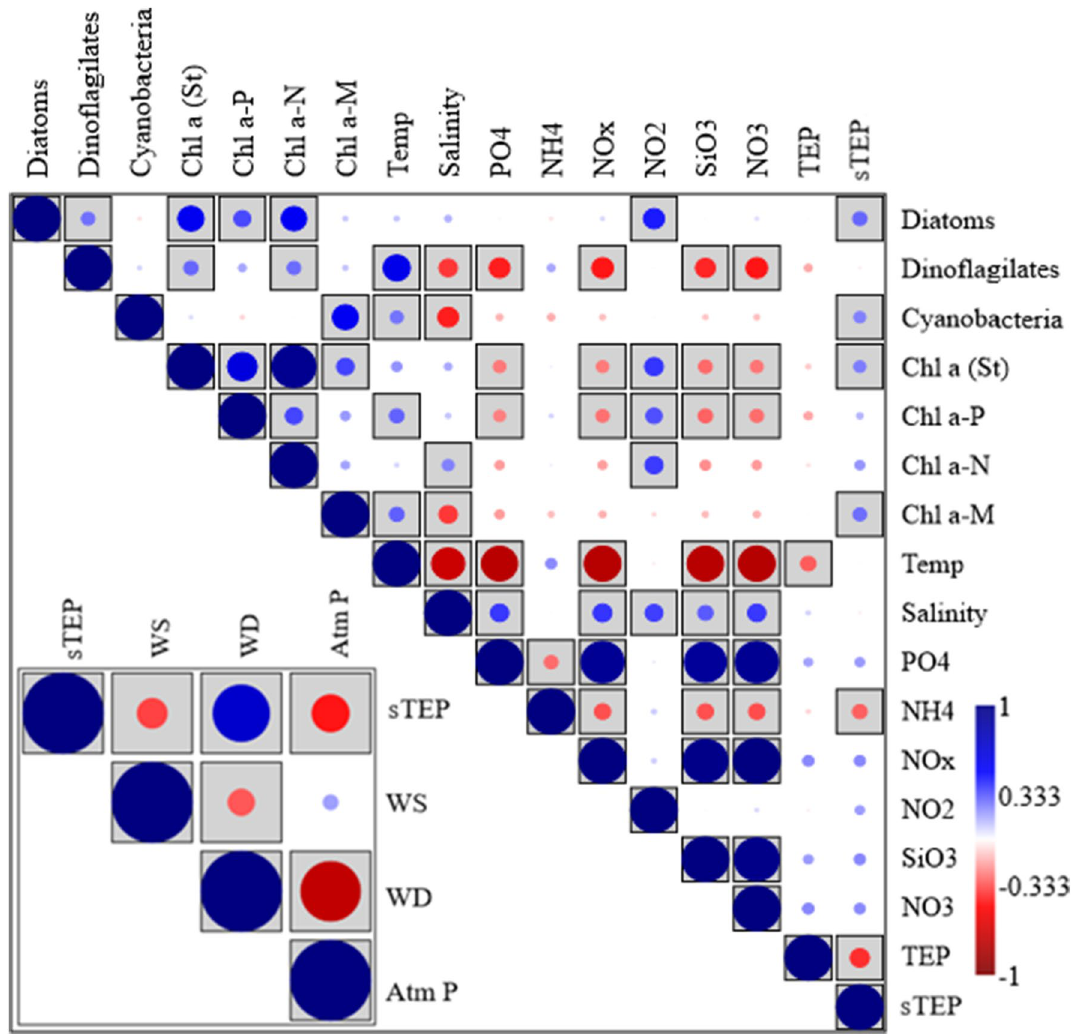
Figure 7. Correlation plots of TEPs and sTEP with other biotic and abiotic parameters after using Pearson’s analysis. The gray box indicates a significant value of P (< 0.05) ( WS wind stress, WD wind direction and Atm P atmospheric